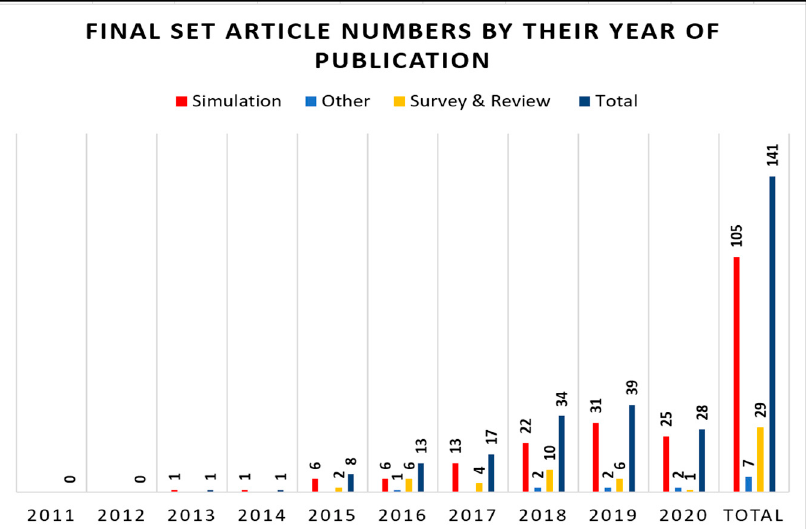
Figure 2. Number of articles’ types based on the year of publication.